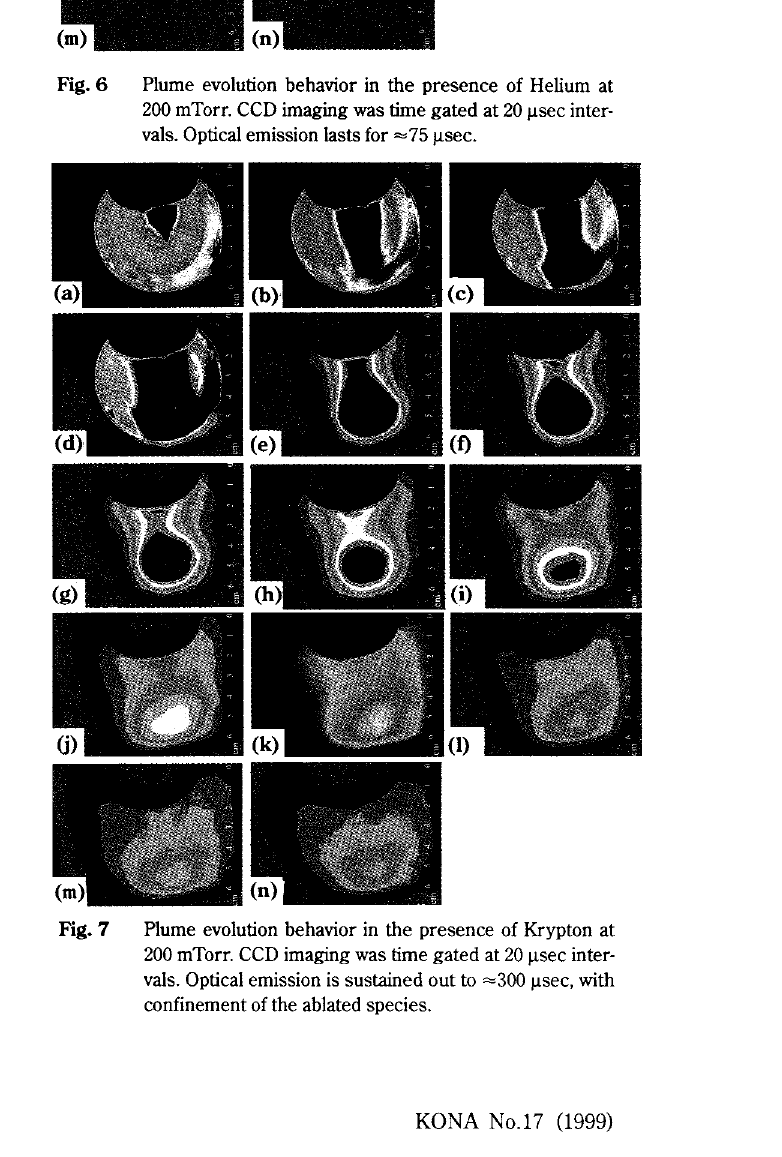
Fig. 6 Plume evolution behavior in the presence of Helium at 200 mTorr. CCD imaging was time gated at 20 )..lSec inter vals. Optical emission lasts for ,75 )..lSec.